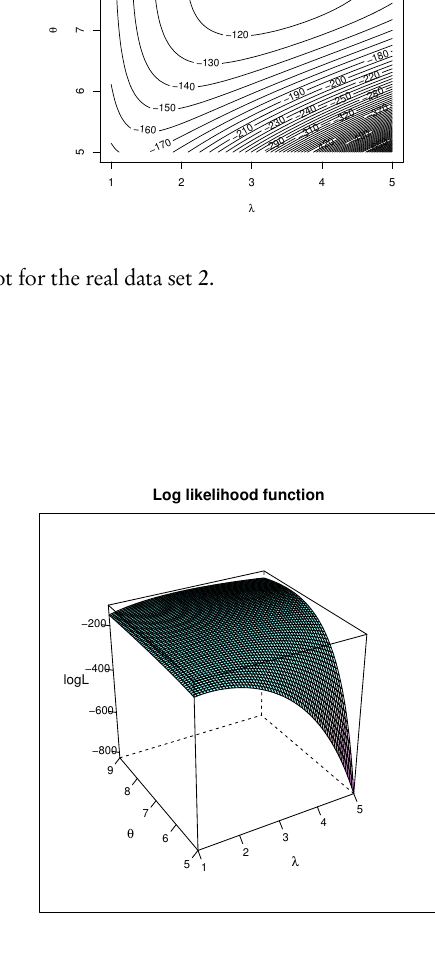
Figure 7 – Log likelihood plot for the real data set